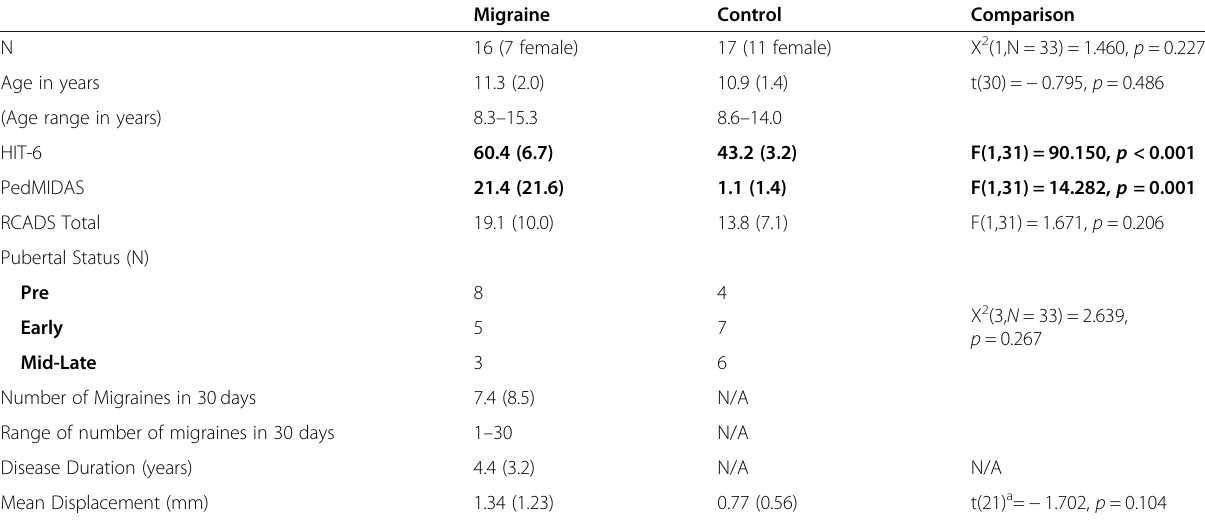
Table 1 Table of demographics and questionnaire results (mean ± standard